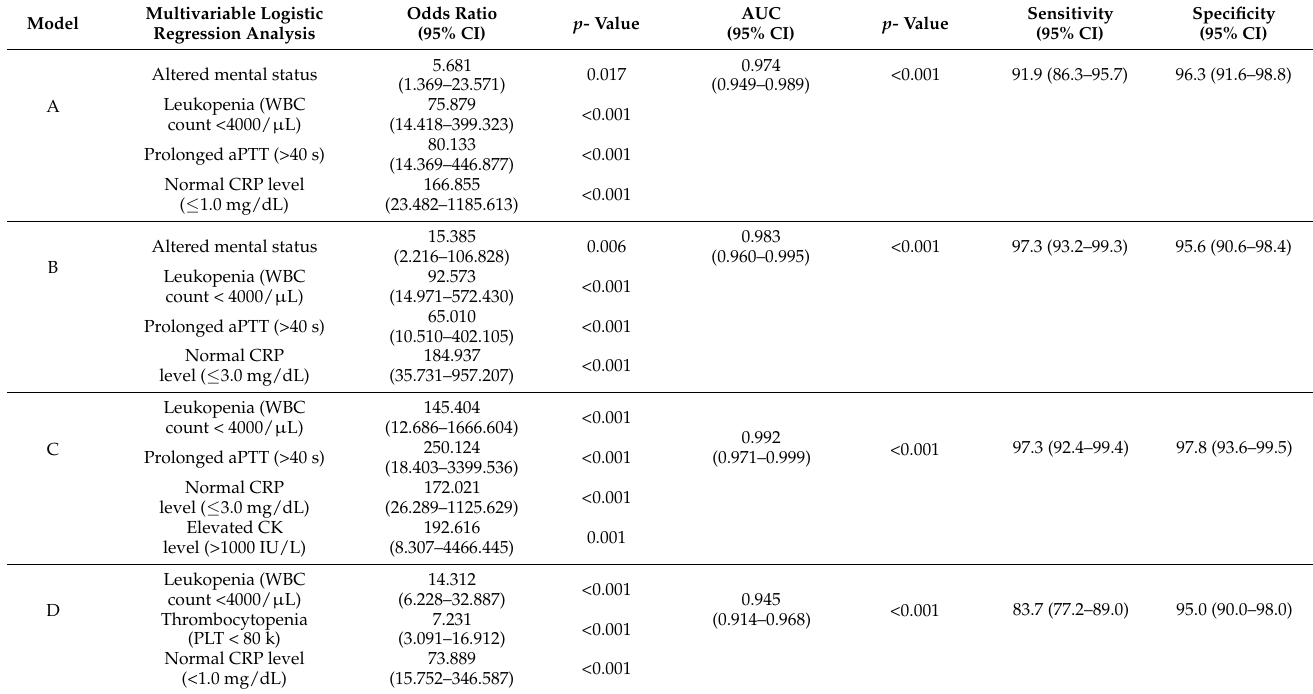
Table 1. Multivariable logistic regression analysis parameters predictive of severe fever with thrombo- cytopenia syndrome and the diagnostic performance of the clinical scoring system in differentiating severe fever with thrombocytopenia